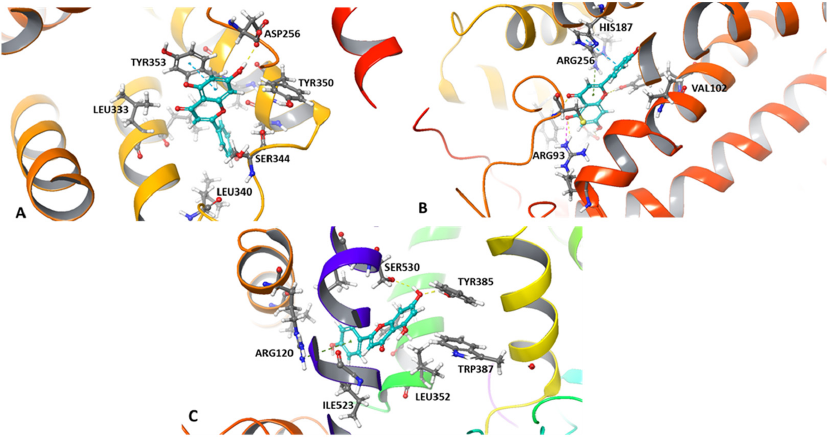
Figure 1. Most favorable docked poses of apigenin in the three receptors and their hydrogen and pi interactions ( A ) PAR-1, ( B ) P2Y12, and ( C ) COX-1.